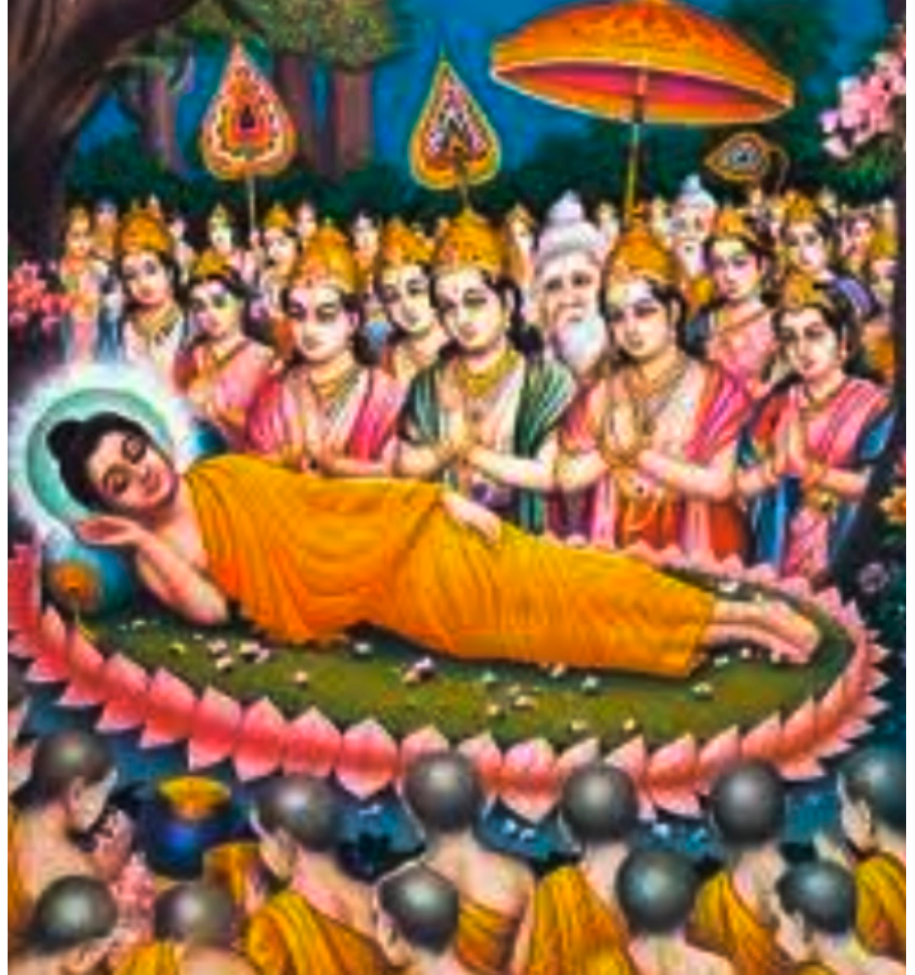
Figure 14. The passing away of Buddha. A